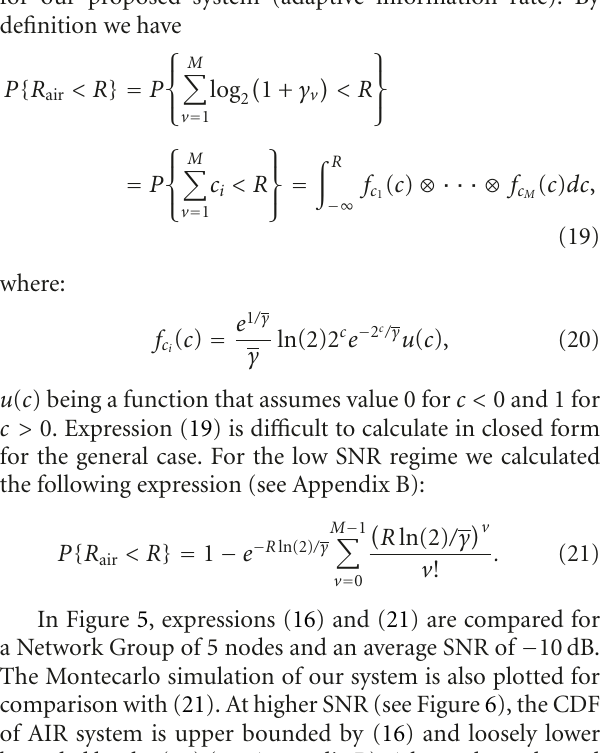
We calculated this expression for a network with a generic number M of nodes (see Appendix A). Such expression